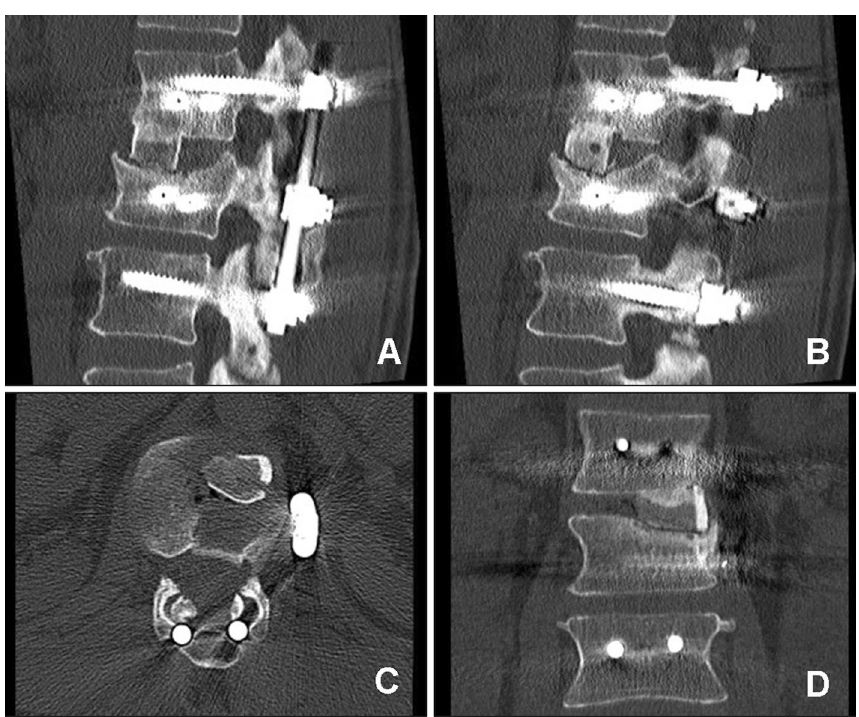
Figure 7. CT of a 41-year-old man (superior incomplete burst fracture of L2, Magerl et al. 19 A3.1.1, AOSpine A3 1 ) 11 months after short segment posterior instrumentation and anterior one-level spondylodesis using an ICBG, showing unipolar nonfusion between the lower part of the iliac crest bone graft and the adjacent vertebrae